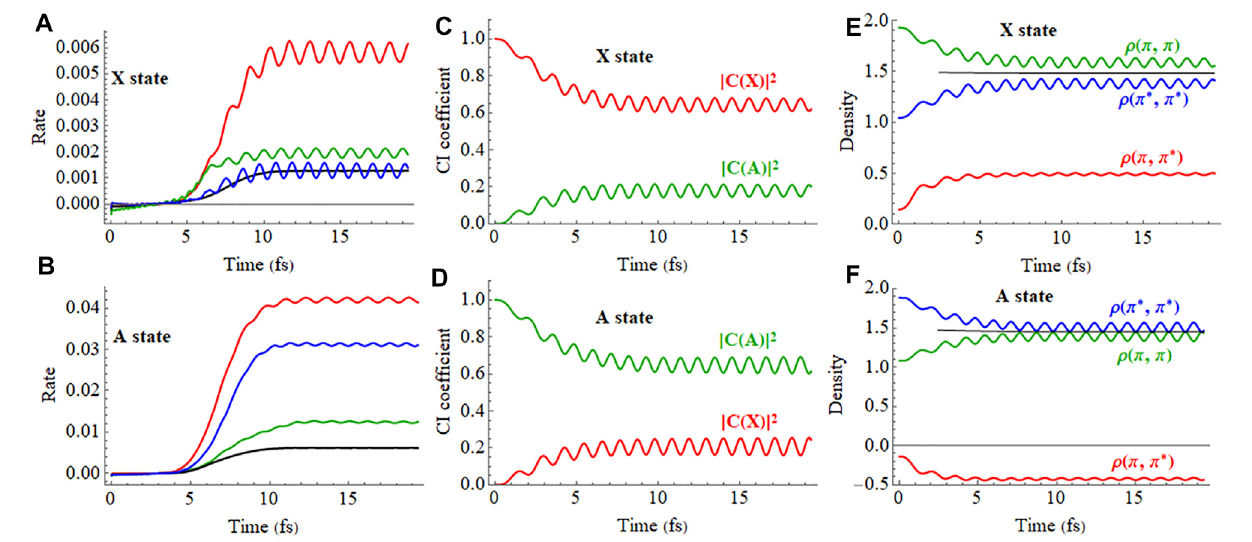
FIGURE 6 | Ionization of the X ( (cid:2) π p − 1 x ) and A ( (cid:2) π − 1 x ) states by static electric fi eld ramped up to 0.055 au. (A,B) The ionization rate for the fi eld along the molecular axis and ionization from the iodine end (blue) and the hydrogen end (green), perpendicular to the molecular axis (black) and at 45 ° to the molecular axis from the iodine end (red). (C,D) CI coef fi cients for the X and A con fi gurations (red and green, resp.) in the normalized wavefunction for the time-dependent X and A states, for the fi eld along themolecularaxisandionizationfromtheiodineend. (E,F) Densitymatrixelementsforthe π